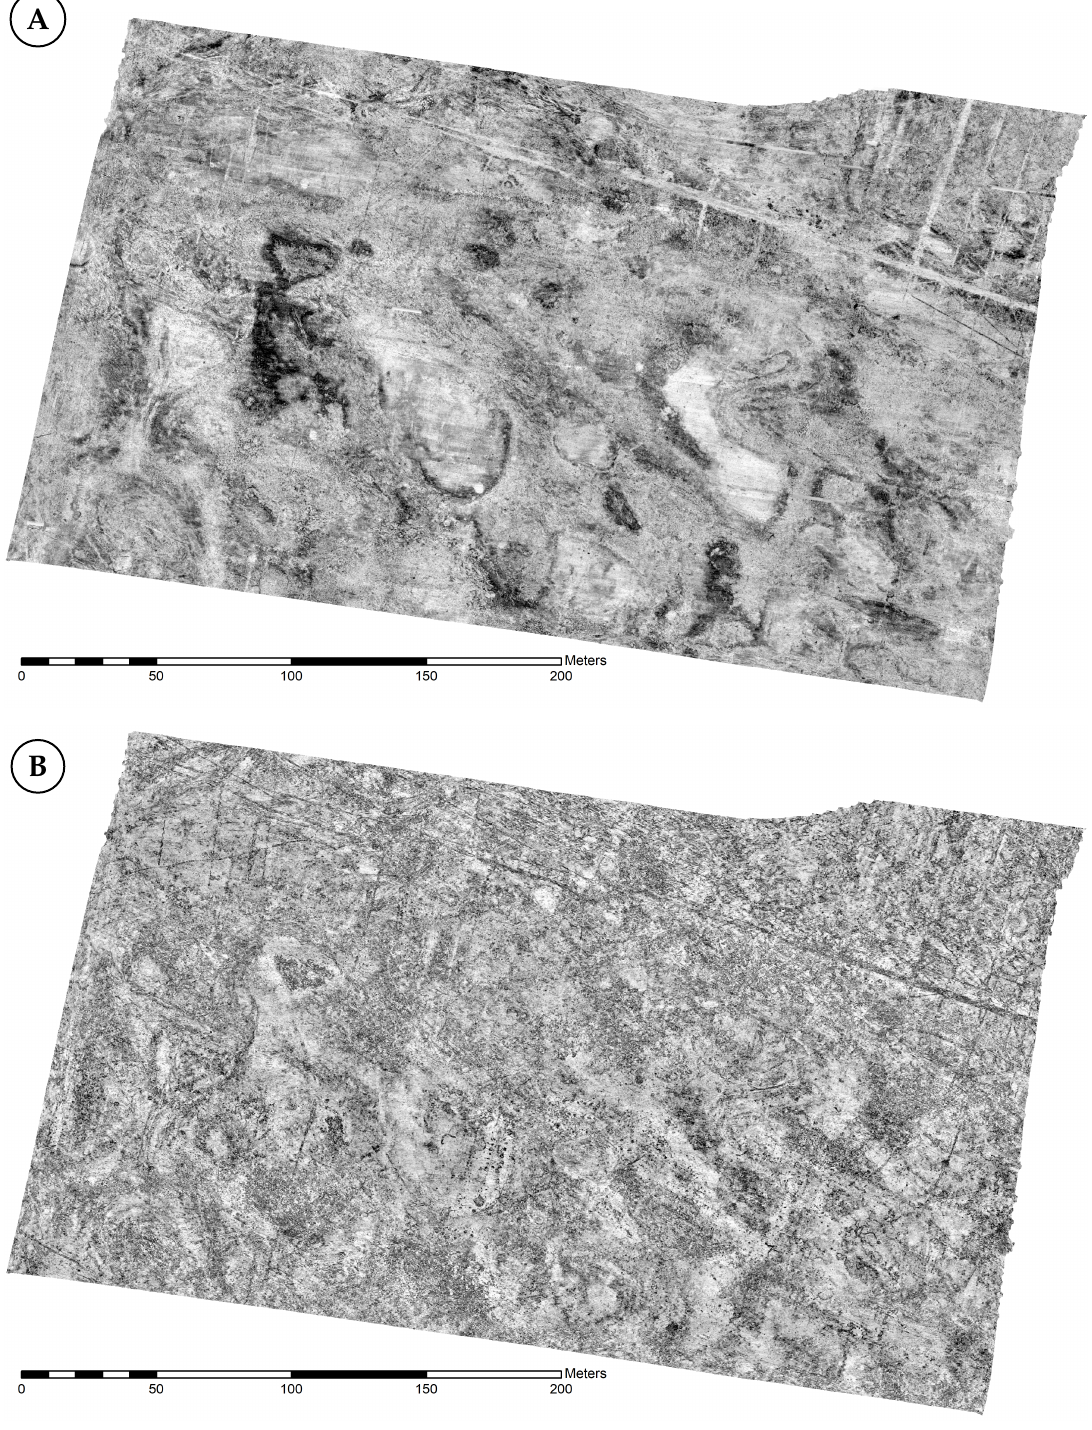
Figure 2. 7.4 ha area GPR survey at Rysensten. ( A ) Conventional GPR amplitude map after Hilbert transformation of the data showing a 5 cm thick depth-slice from approximately 40–45 cm depth. ( B ) Coherence map for the same depth range. North is pointing upwards for all data figures in this